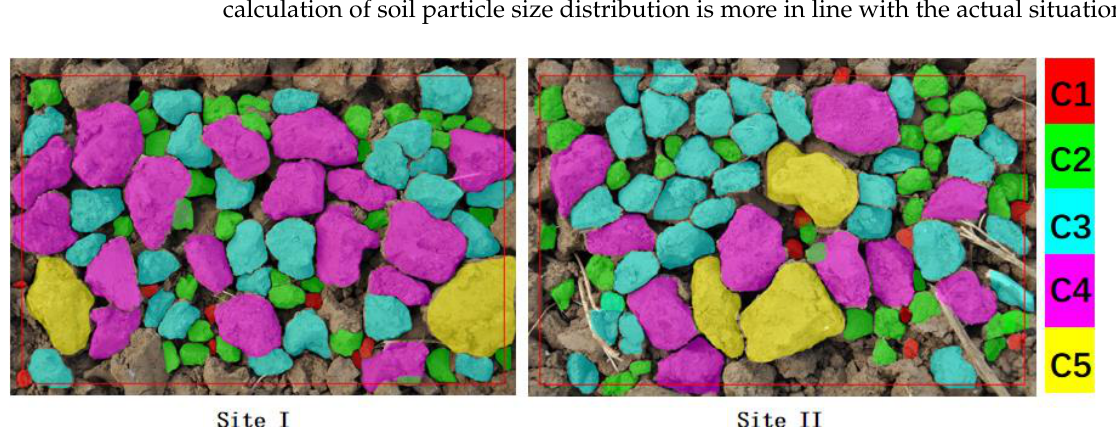
Figure 12. Simple schematic for edge-removal incomplete blocks.